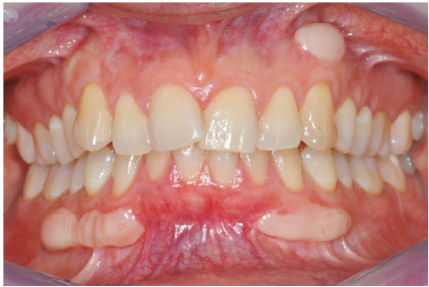
Figure 1: Clinical aspect at